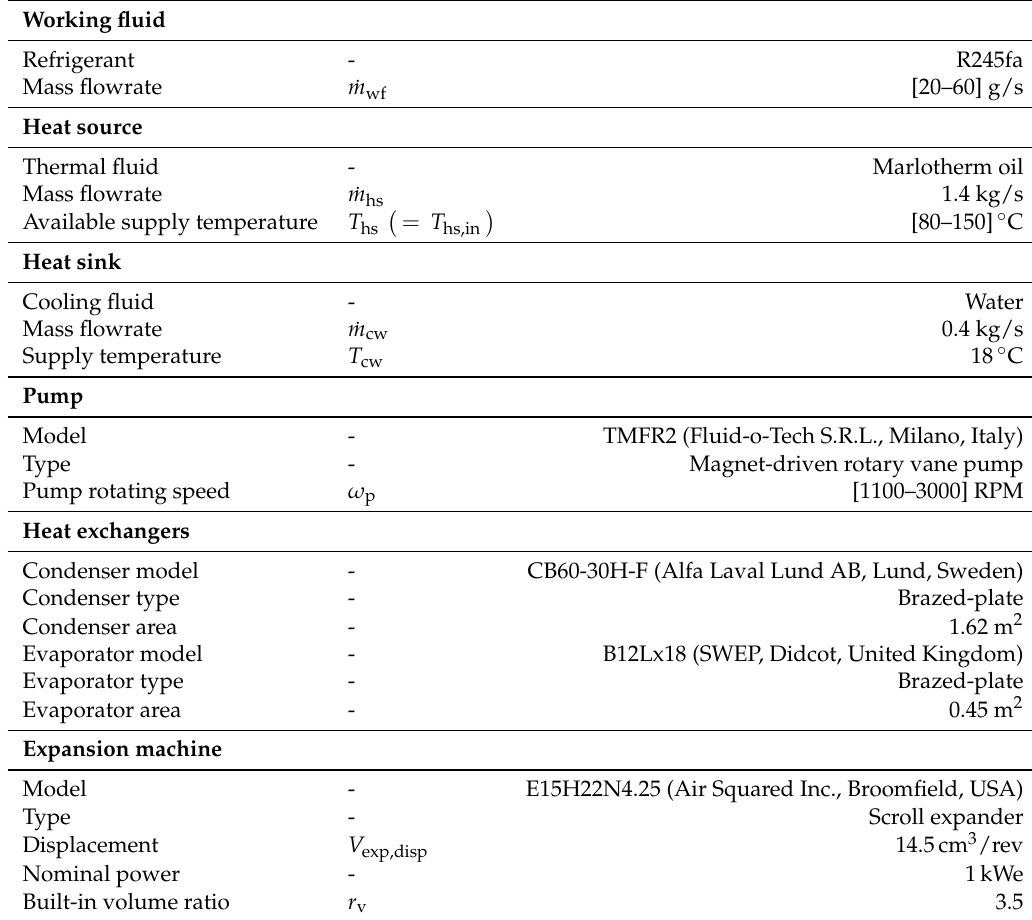
Table 1. ORC testing facility